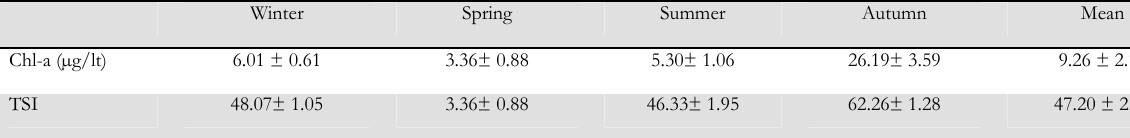
Table 2. Total length and weight parameters of C. gibelio by sexes